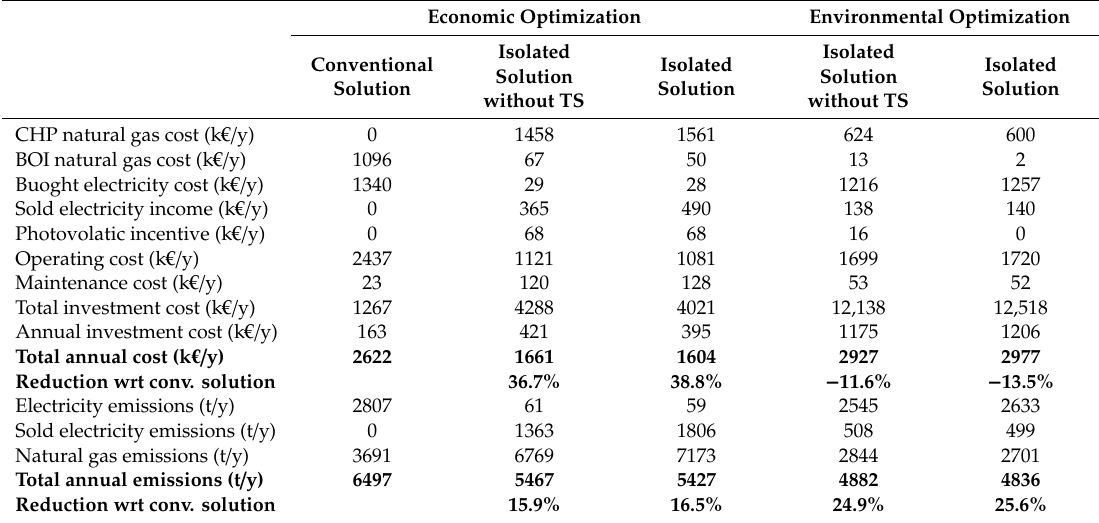
Table 7. Total economic and environmental results of the optimizations—isolated